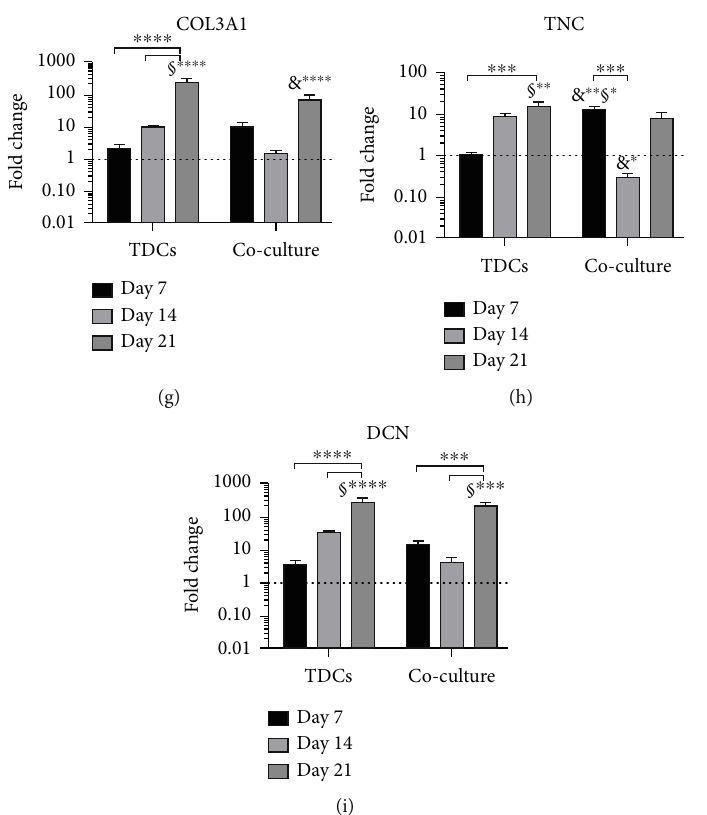
Figure 7: (a – c) Nuclear aspect ratio and cell proliferation at 3, 7, and 14 days; results are presented as mean ± SEM . (d – i) Expression of tendon-related genes in single and coculture conditions: (d) Scx, (e) MKX, (f) COL1A1, (g) COL3A1, (h) TNC, and (i) DCN. Reproduced with permission from reference